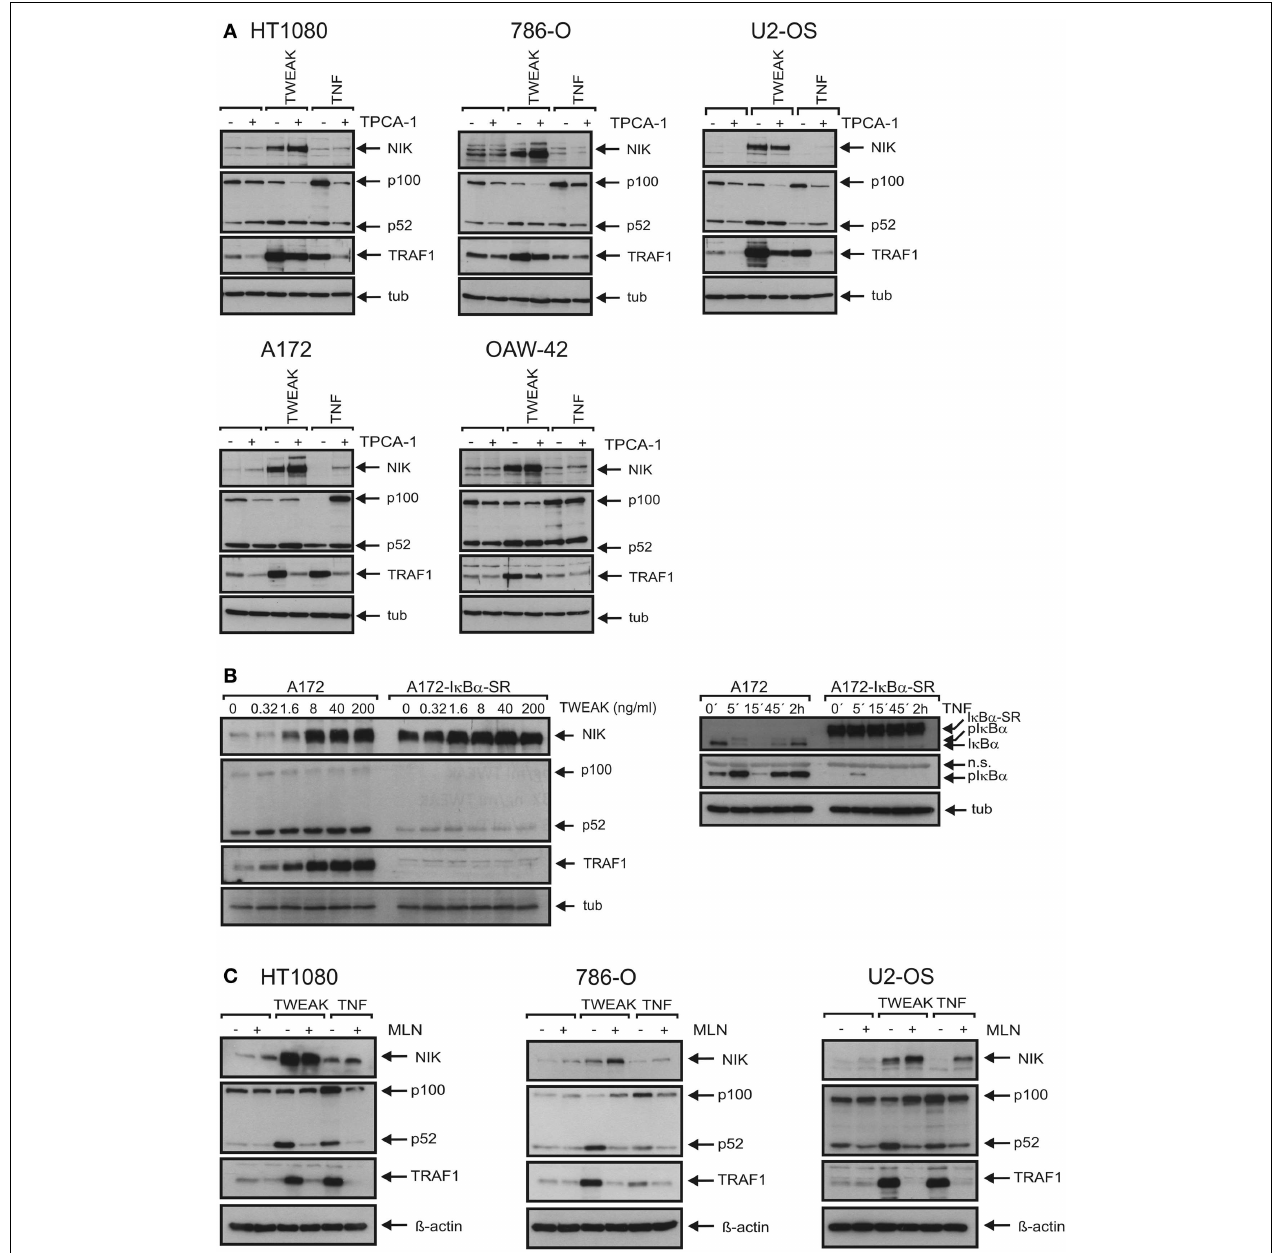
cell extracts forTRAF1 production and activation of the alternative NF κ B pathway (left panel). Efficacy of I κ B α -SR-mediated repression of the classical NF κ B pathway was proved by analyzing phosphorylation and degradation of I κ B α in cells stimulated withTNF (100ng/ml) (right panel). (C) The indicated cell lines were pretreated or not with 10 µ M MLN4924 for 30min and then stimulated with Flag-TWEAK (200ng/ml) and Flag-TNF (100ng/ml).The next day, total cell lysates were prepared and analyzed for the presence of the indicated proteins by western blotting.